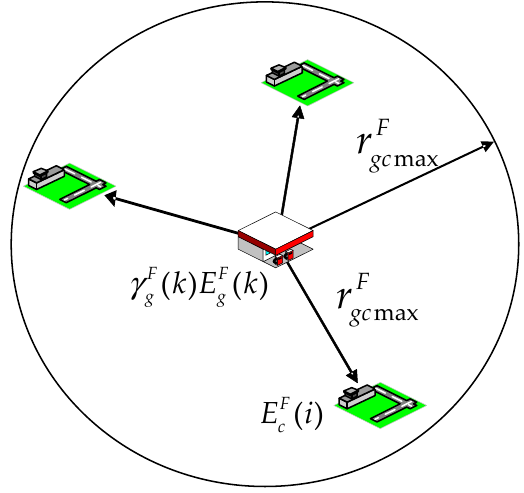
Figure 4. The transfer of FEEQ from gas stations to CCIs.